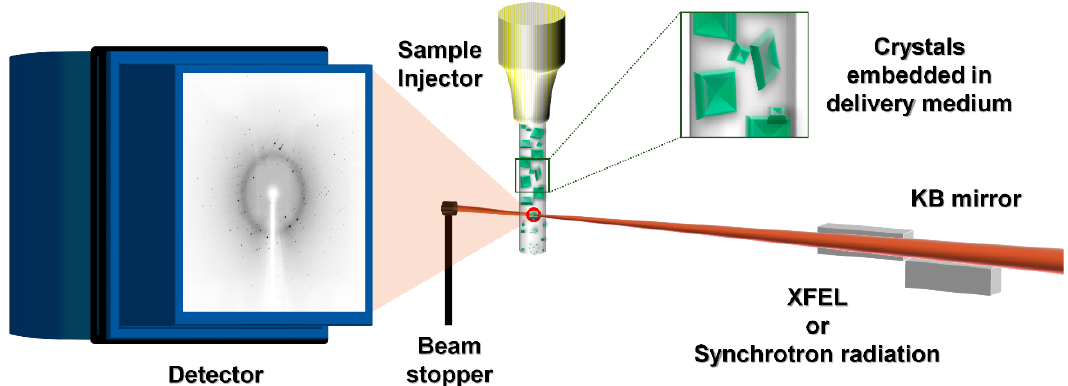
Figure 1. Schematic diagram of experimental geometry for serial crystallography using sample delivery medium. XFEL (X-ray free electron laser) or the synchrotron X-ray is focused using Kirkpatrick-Baez (KB) mirrors. The injection stream of the delivery medium containing crystals is extruded from the sample injector into the X-ray interaction point (red circle). The single panel detector without a center hole is the required beam stopper. Diffraction data is recorded by the detector.